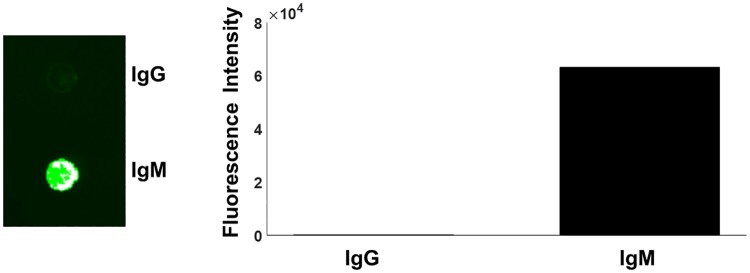
Specific detection of IgM antibodies using the plasmonic chip.(Left) Example image of a plasmonic chip with IgG (upper) and IgM (lower) antibodies arrayed and tested using serum from volunteer followed by probing with Cy3 conjugated anti-IgM antibodies demonstrates specificity for detecting IgM with extremely low cross-reactive detection of IgG isotype antibodies. (Right) Quantification of the fluorescence intensity of the signal from IgG and IgM arrayed spots using a Genepix 4000B scanner.